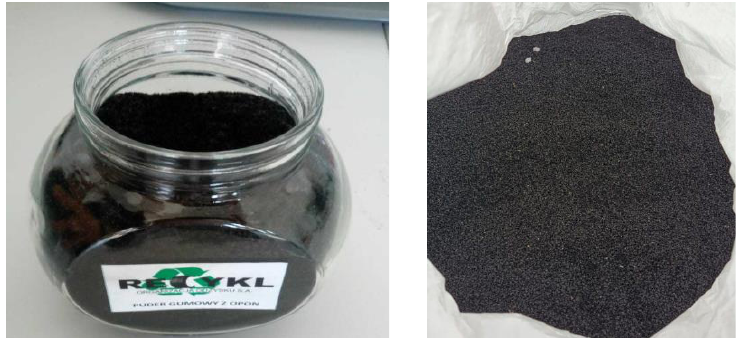
Figure 1. Rubber powder made from recycled tires. Source: Photo taken during the research.